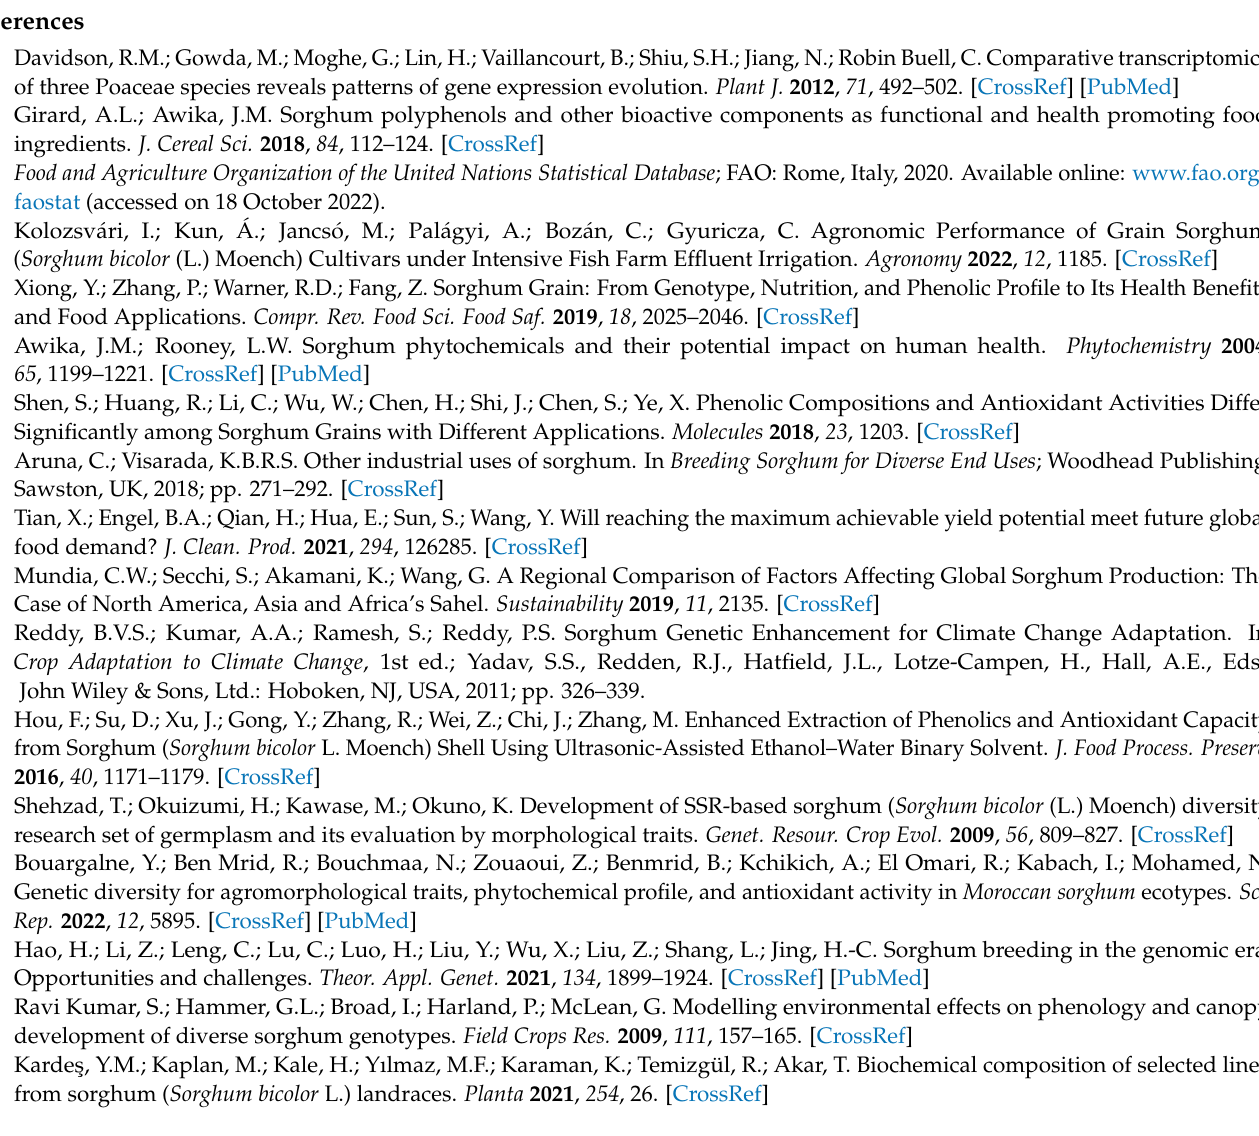
Table S2: Statistical data of analysis of variance indicating the variation in biochemical and agronom- ical traits among sorghum genotypes; Table S3: Variation in metabolite contents and antioxidant activities in sorghum landraces according to the collection area; and Table S4: Variation in